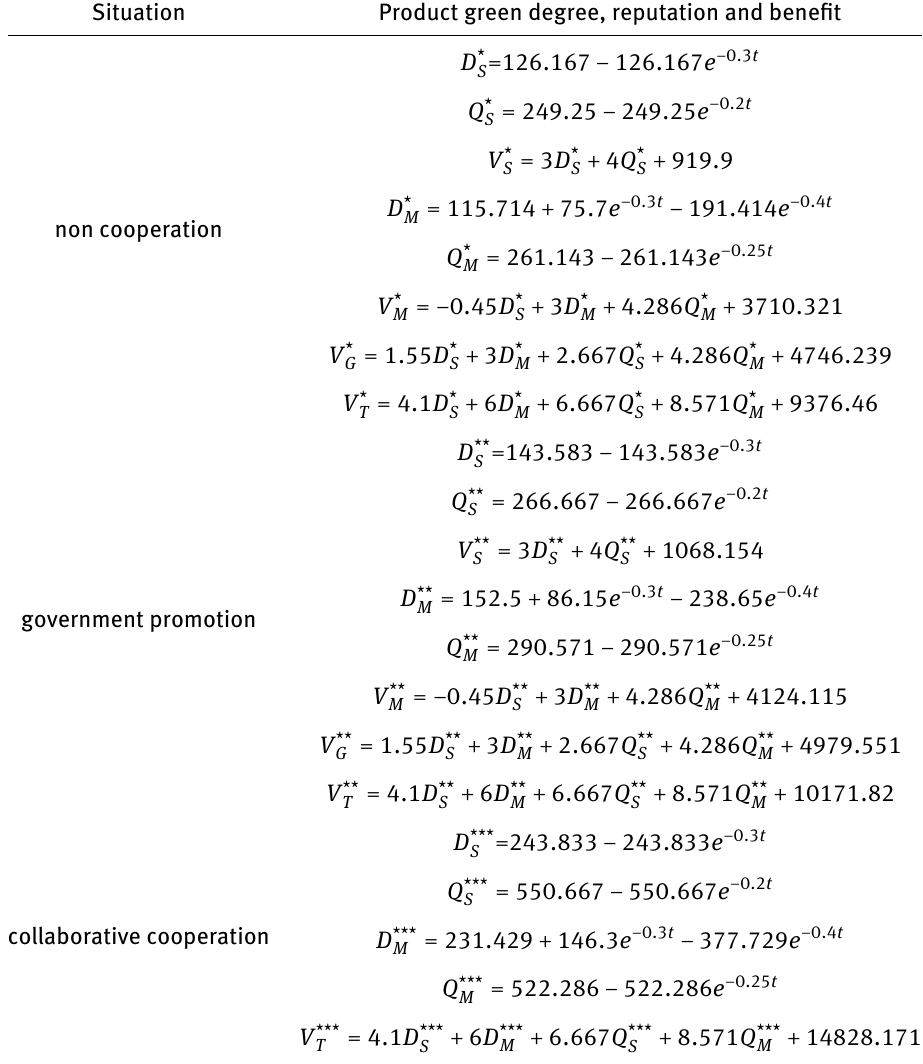
Table 3: Product green degree, reputation and benefit in different